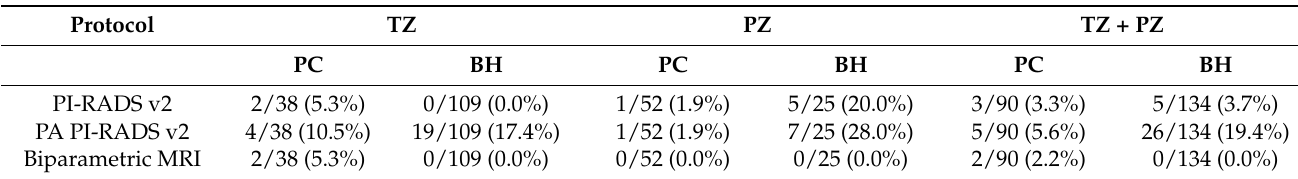
Table 3. Lesions of category 3 (according to the primary determining sequence) upgraded to category 4 after being combined with other sequences.